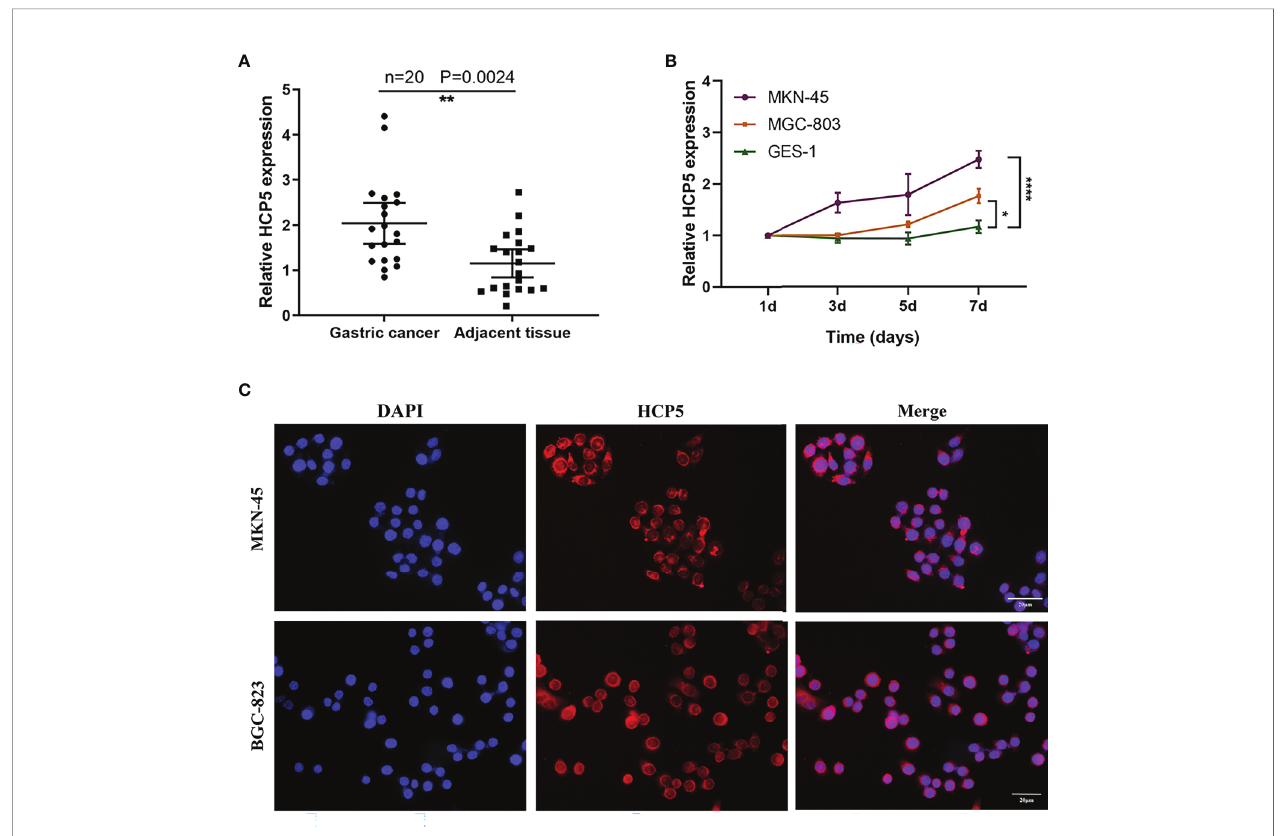
FIGURE 3 | The origin of serum HCP5 in GC cases. (A) The expression level of HCP5 in 20 pairs of GC tissues. (B) HCP5 was secreted into the culture medium by MKN-45 and MGC-803 cells in a time-dependent manner. *P < 0.05, **P < 0.01, ****P < 0.001. (C) The FISH assay of HCP5 in MKN-45 and BGC-823 cells. Scale bars: 20 m